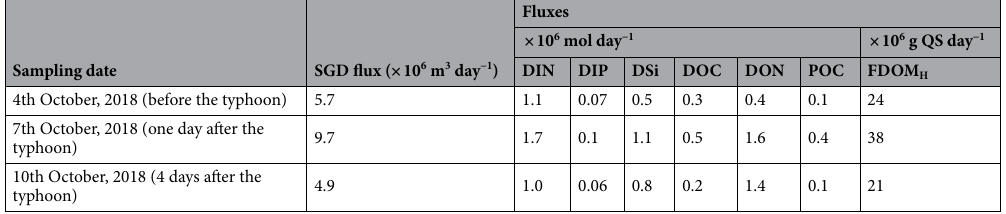
Table 1. Fluxes of dissolved inorganic nutrients and organic matter via SGD in Hwasun Bay of Jeju Island during each sampling campaign. The calculated SGD-derived nutrient and organic matter fluxes have combined uncertainties ranged from 110 to